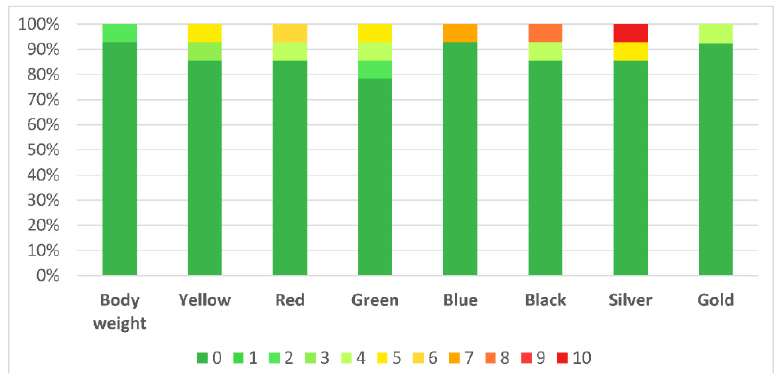
Figure 7. Percentage of intensity-related pain for every condition.